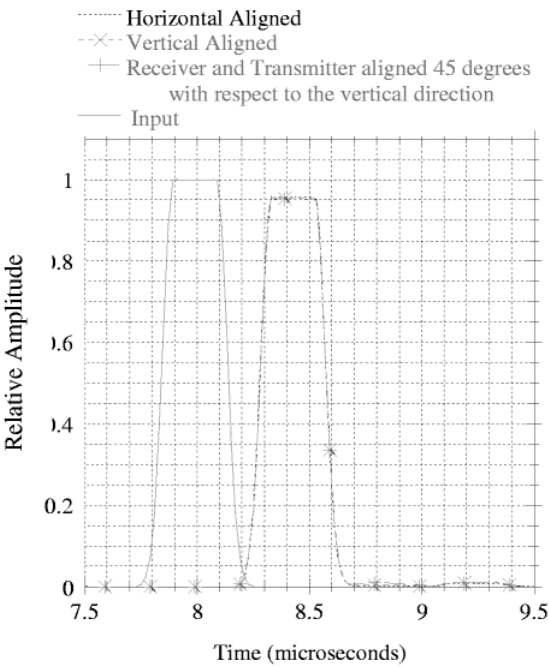
FIG. 24. Time domain response of the transport line plus the mode launchers (two mode transducers plus two arc tapers). For this figure, the two mode transducers were always aligned with respect to each other.